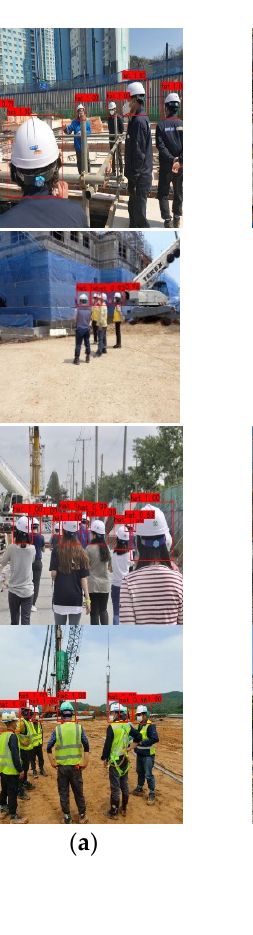
Figure 12. Model size vs. mAP. Details are in Table 4. Note that our approach obtains higher accuracy while having less model complexity.